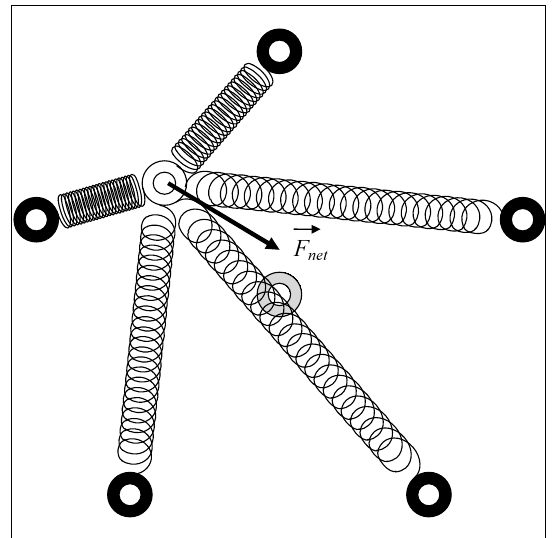
Figure 1. The simple example of five beacons and a sensor.